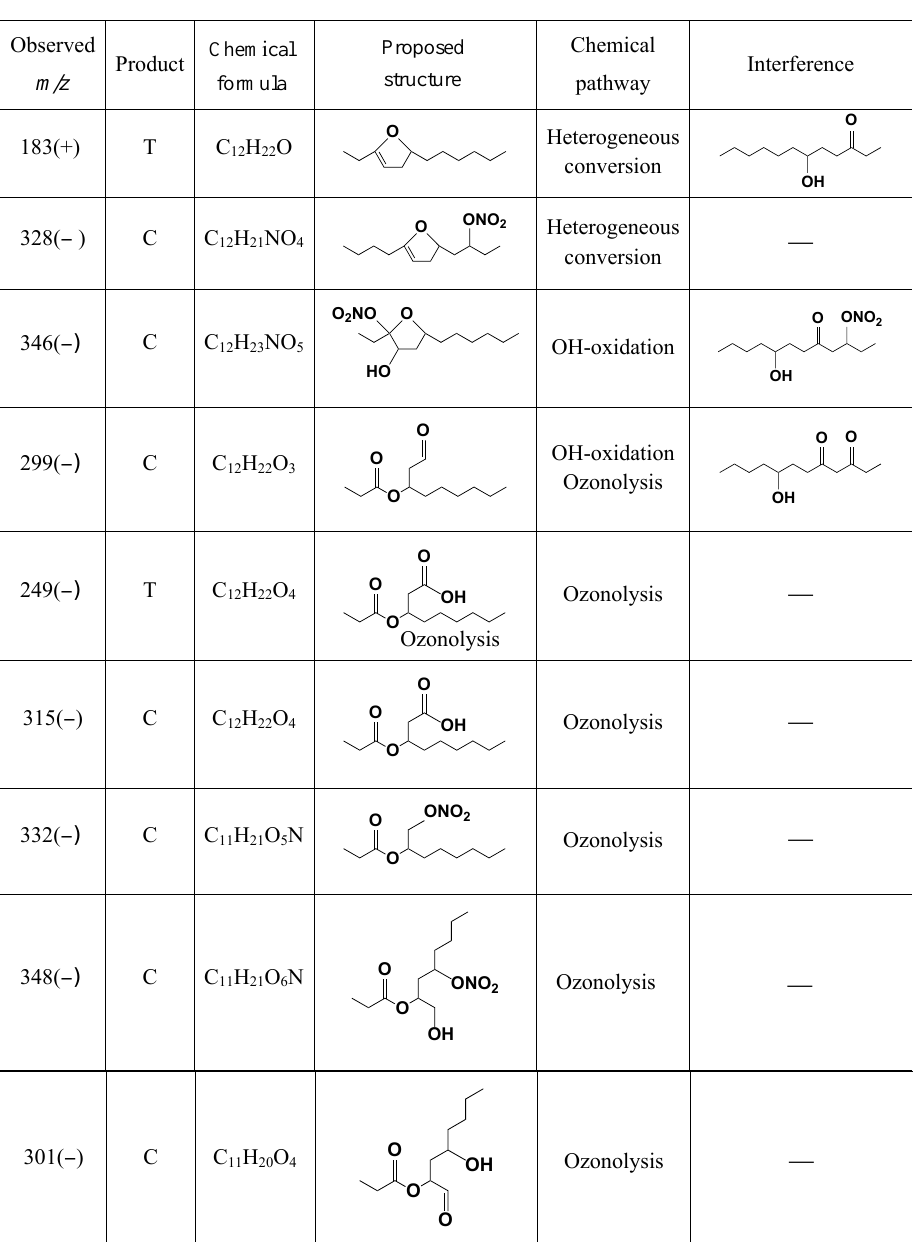
Table 2. Proposed structures for CIMS ions unique to the alkyl-substituted dihydrofuran chemistry. C and T indicate the cluster and transfer product, respectively. Commercial standards are not